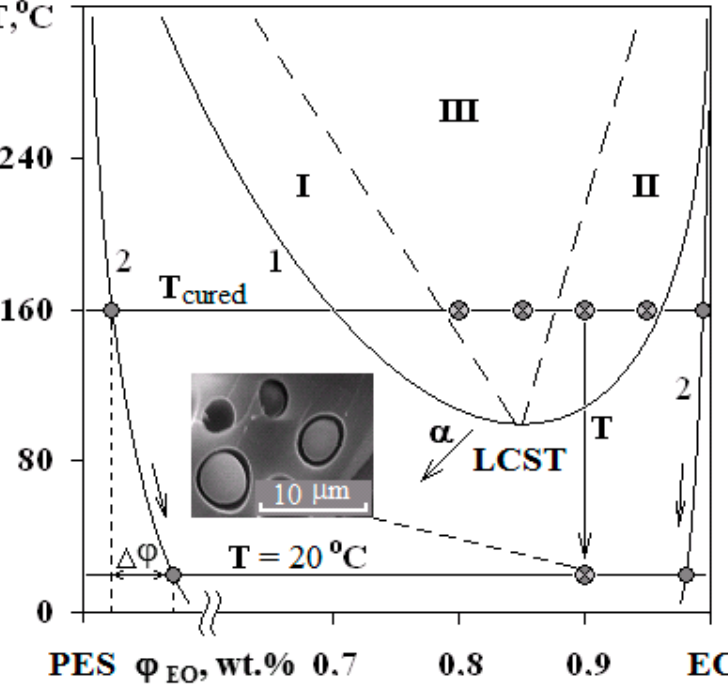
Figure 11. Evolution of the PD of the PES–EO system during the curing reaction. The arrow α indicates the direction of the critical temperature shift with increasing α . Other arrows indicate the change in the composition of the phases with decreasing temperature of the cured system. ∆ ϕ is the composition shift of the dispersed phase in the cured mixture at room temperature. The micrograph shows the phase structure of the mixture at 10 wt.% of PES.